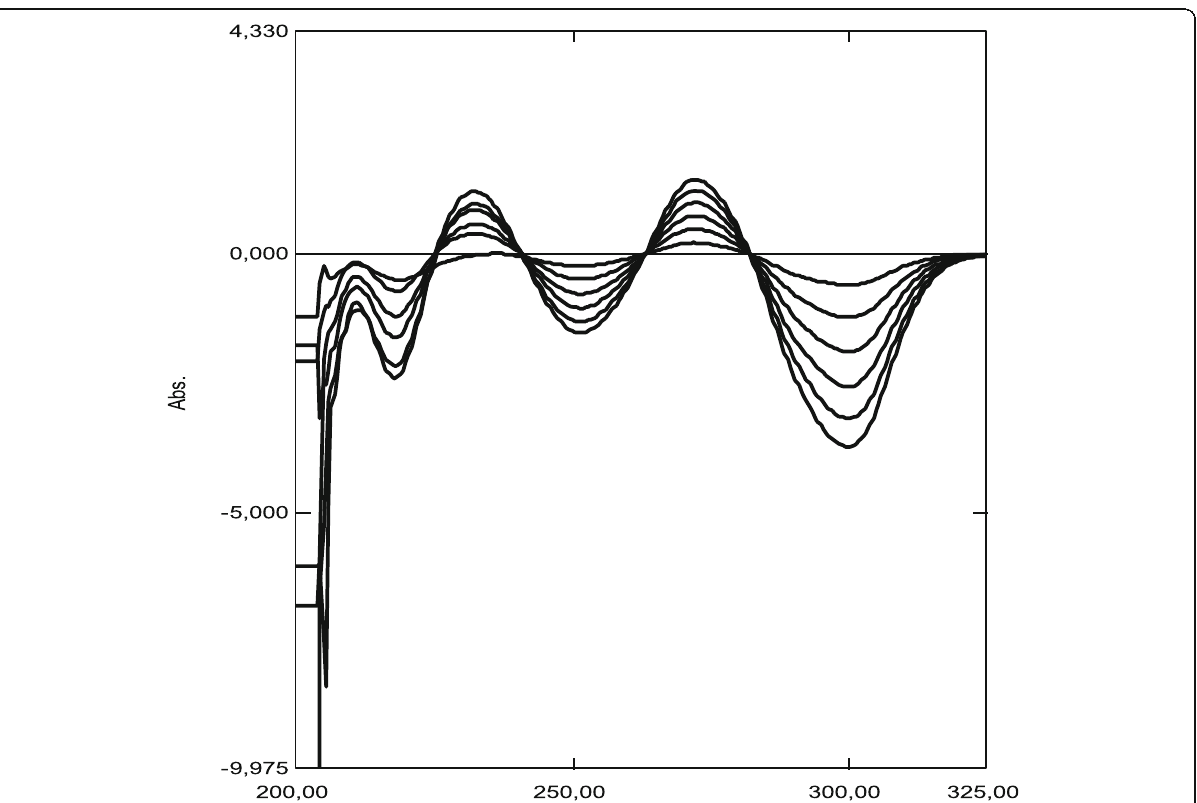
Fig. 11 Chromatograms of the tenofovir calibration solutions. (1) Tenofovir. (2) Ritonavir. Retention times of tenofovir and ritonavir are 2.64 and 3.07 min,